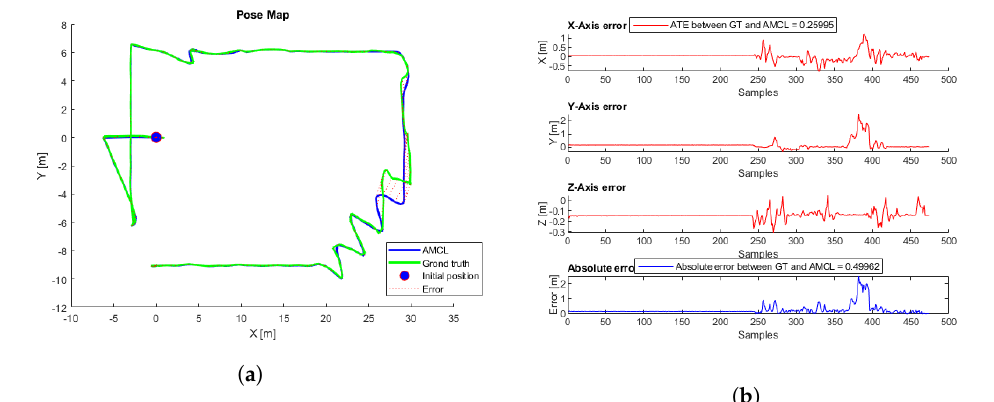
Figure 29. ICP-NL simulation test with the lowest ATE. ( a ) Trajectories. ICP-N (blue), ground truth (green), take-off position (blue circle), error (red). ( b ) ICP-N errors.